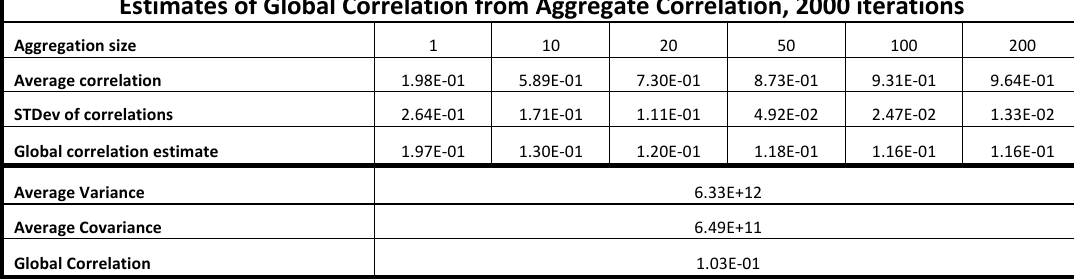
Table 1: US crop loss insurance claims from 1330 counties without null entries, 1980 - 2008.